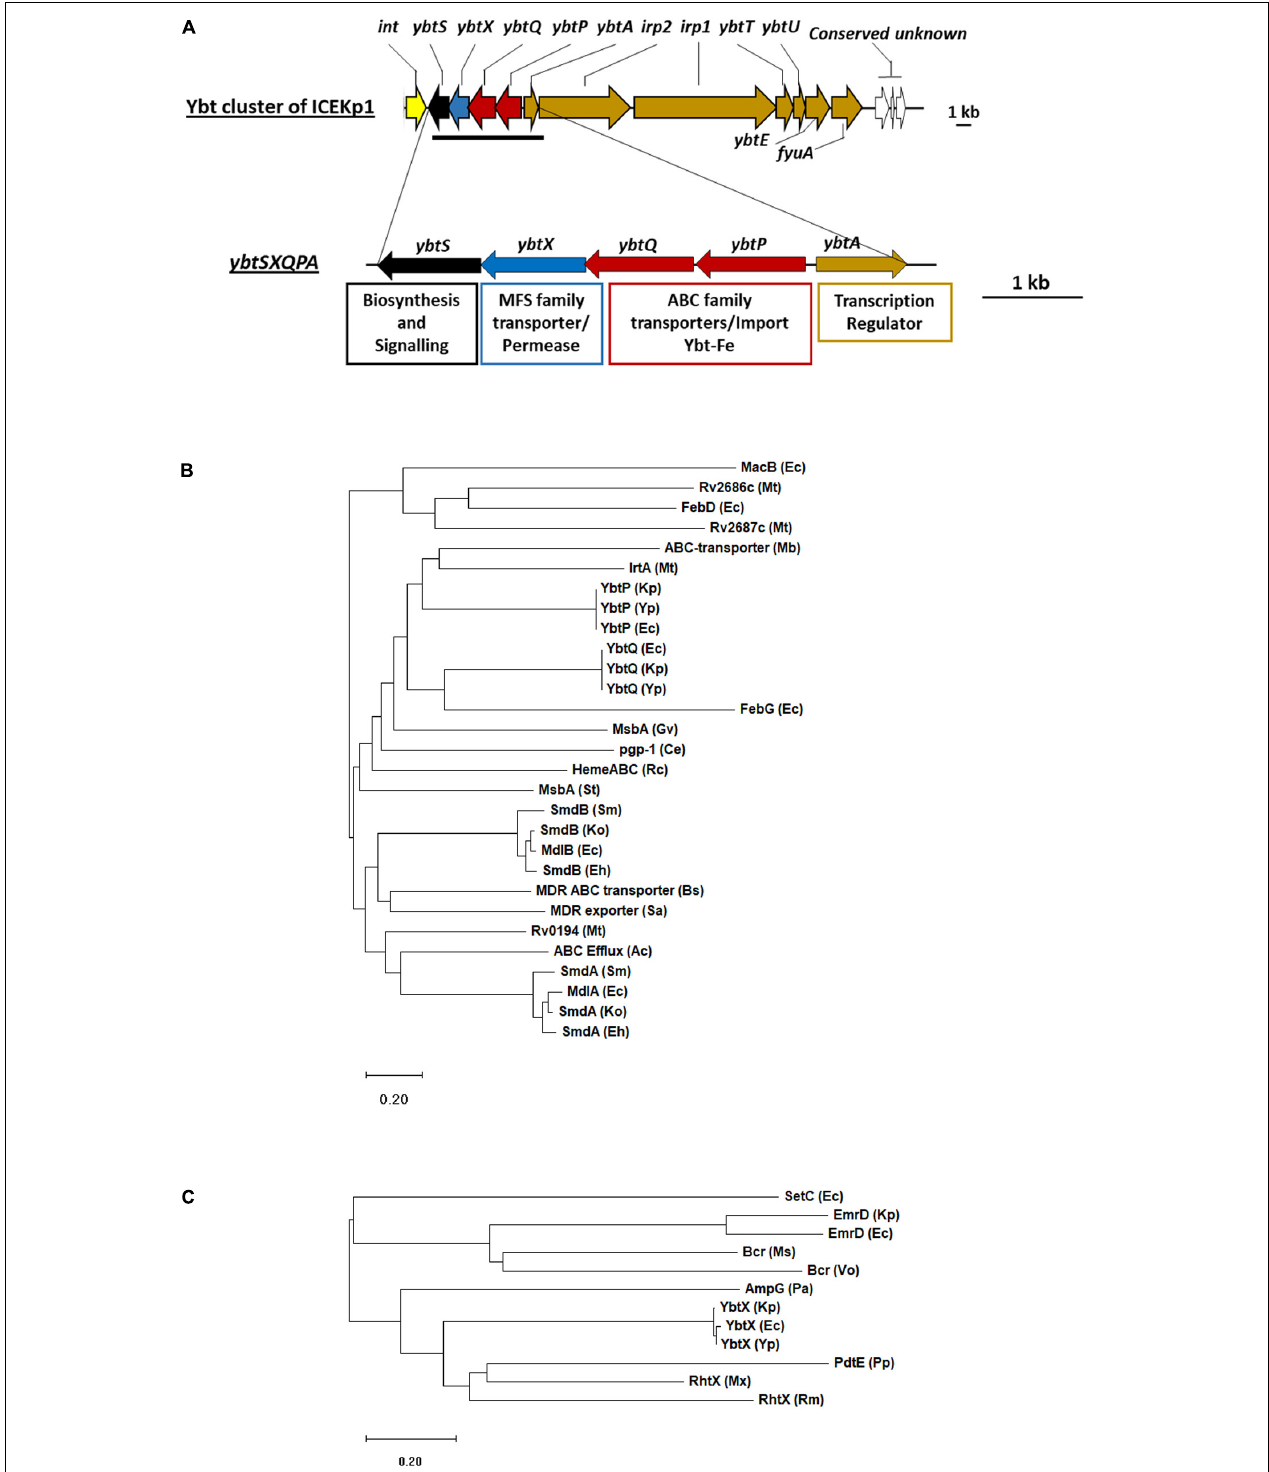
FIGURE 2 | The cargo genes of ICEKp from K. pneumoniae KpRR2 are an iron siderophore biosynthesis cluster (yersiniabactin) that includes an ABC transporter and an MFS family permease. (A) The entire cargo genes of ICEKp are shown, with annotation. The only transmembrane transporters amongst the cargo genes are in the four-gene operon: ybtP-ybtS . This operon is unique to yersiniabactin clusters and conserved with > 80% amino acid identity in all organisms. The previously reported deletion strain (cid:49) ICE lacks the entire ICEKp (and therefore lacks the entire yersiniabactin cluster). (B) YbtP and YbtQ share 34% amino acid identity with each